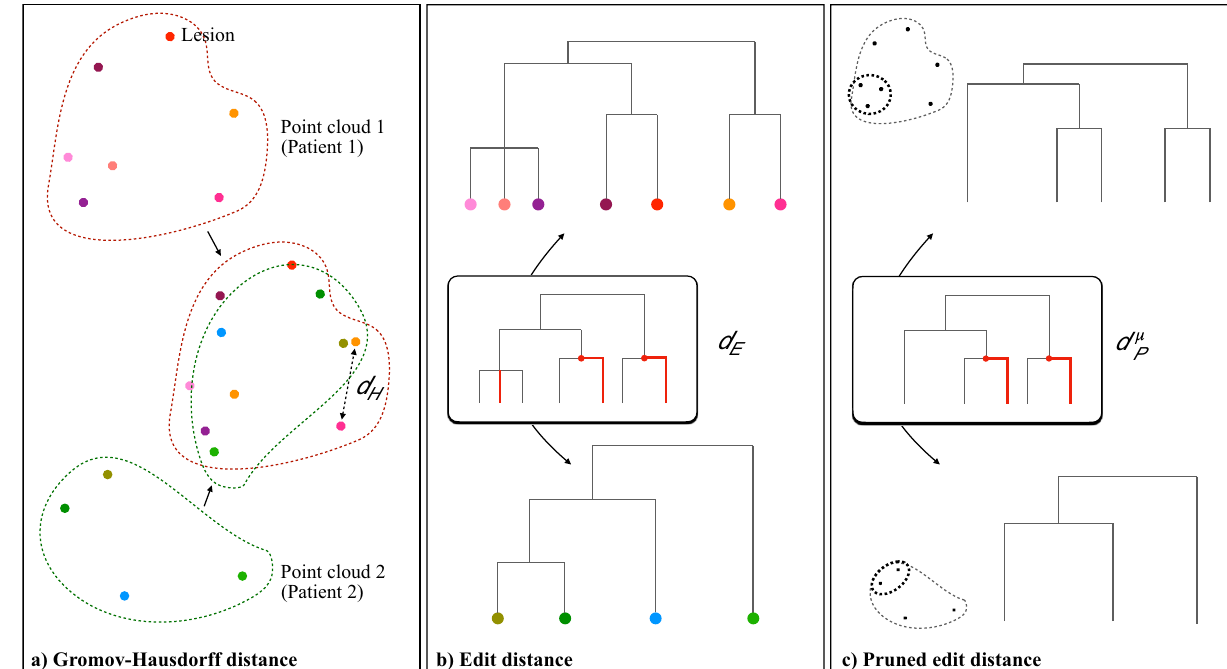
Figure 6. Continuity among metrics. ( a ) Gromov-Hausdorff distance between two point clouds: the point clouds get overlapped and d H is defined as the maximum distance between the two maximally distant points; Gromov-Hausdorff-closeness reflects the similarity in the spreading of points of two point clouds throughout the space. Specifically in the radiomic space, such spreading entails the quantification of inter-patient heterogeneity. This means that Gromov-Hausdorff-close point clouds, i.e., patients’ sets of lesions, have similar intra-patient heterogeneity characterization and thus should be regarded as similar by the metric we employ for dendrograms; ( b ) Tree edit distance d E between hierarchical clustering dendrograms: the distance is given by the sum of the costs of the minimum number of modifications needed for transforming a tree into the other. Modifications include positive/negative shrinking, deletion/insertion and ghosting/splitting. The shrinking edit multiplies the weight value of an edge with a positive factor, which can either lengthen (positive shrinking) of shorten (negative shrinking) the original edge weight. The cost of shrinking an edge is equal to the absolute value of the difference between the initial and the final weights. Deleting or inserting an edge ( v 1 , v 2 ) removes or introduces a branch at a given height, altering the children-father structure of the tree. For any deletion/ insertion, the cost is equal to the weight of the edge deleted/inserted. Finally, the ghosting edit eliminates a vertex v that connects only two adjacent edges (order 2 vertex) such as one new edge results from the sum of the two former edges. The opposite edit is the splitting . Ghosting and splitting have no cost, therefore order 2 vertices are de facto irrelevant when computing the cost of an edit path; ( c ) Pruned tree edit distance between pruned dendrograms: pruning removes leaves with weights ≤ ε , eventually aggregating homogeneous phenotypes. The operator P ε thus gradually discards intra-patient homogeneity, disclosing only the heterogeneous— µ d E since the pruning modulates the effect independent—tumor phenotypes. Of note, d P is different from of cardinality on the distance computation by removing redundant edges of the tree and compressing tree